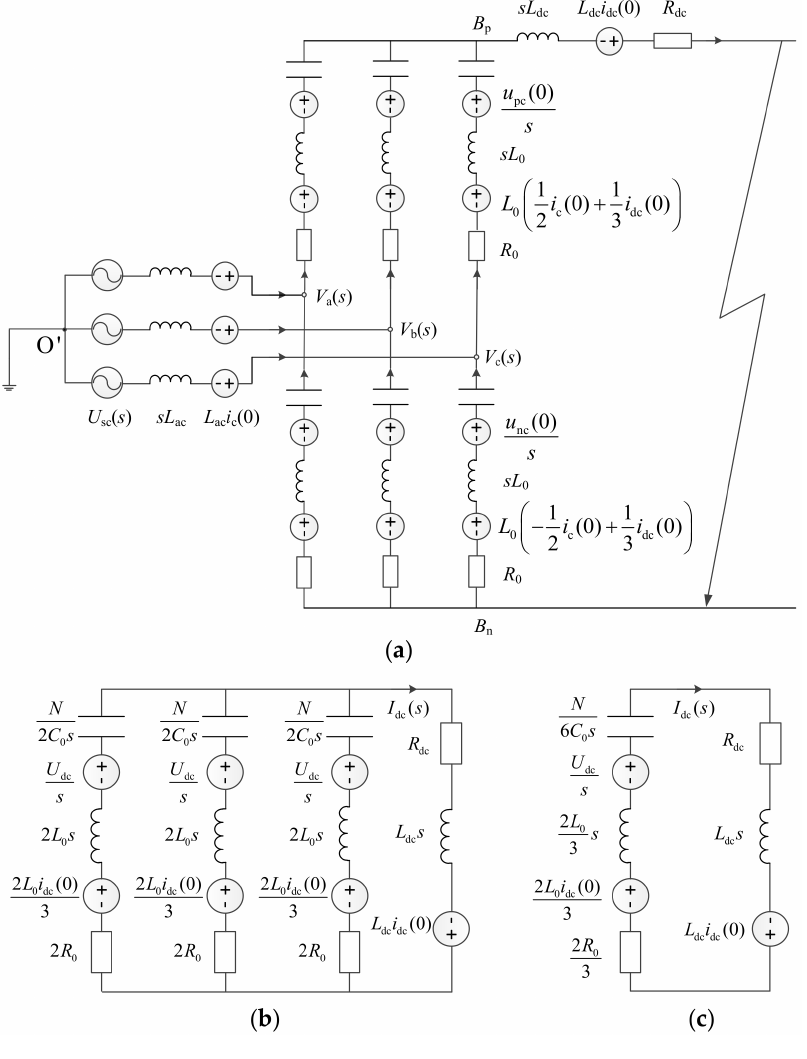
Figure 3. Operation circuit of MMC before it is blocked. ( a ) Complete model; ( b ) Simplified model; ( c ) Equivalent simplified